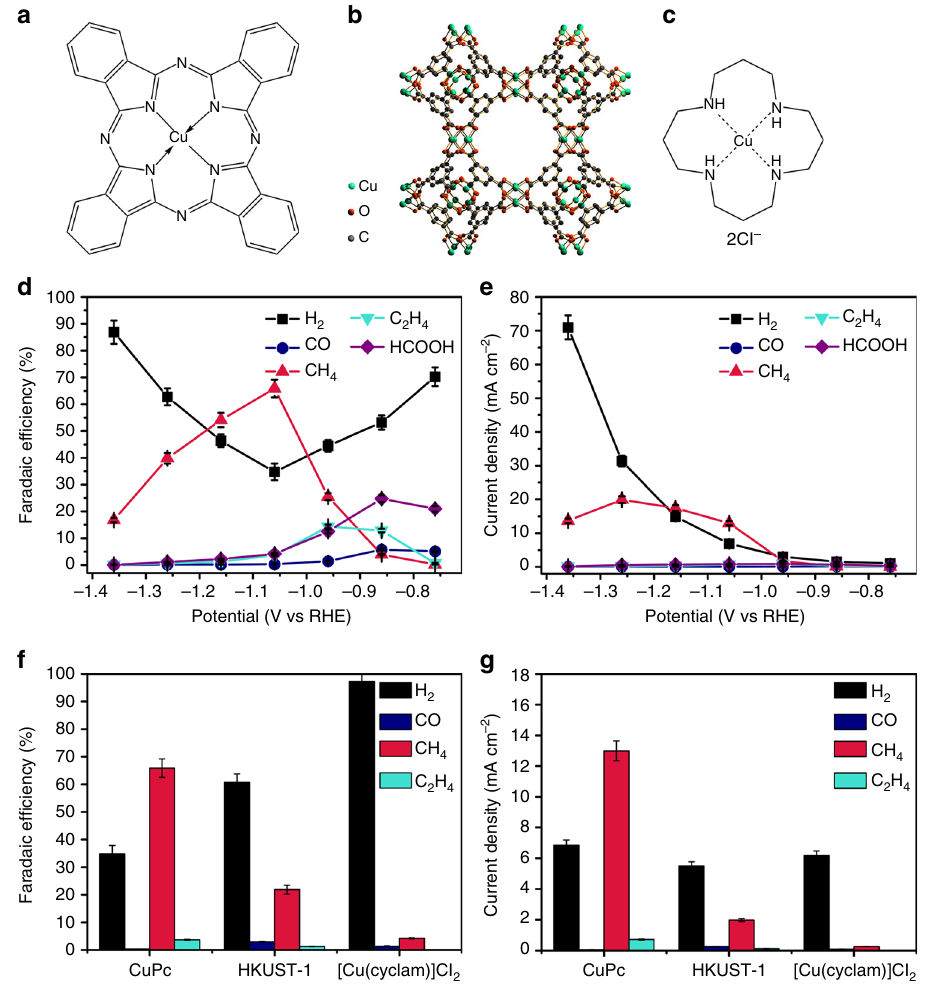
Fig. 1 Molecular structures of three Cu-complex materials and their electrocatalytic performance for CO 2 reduction. Molecular structures of a CuPc, b HKUST-1, and c [Cu(cyclam)]Cl 2 . Potential-dependent d Faradaic ef fi ciencies and e partial current densities of products for CO 2 electroreduction reaction catalyzed by CuPc. Comparison of f Faradaic ef fi ciency and g partial current density distributions among CO 2 electroreduction reactions catalyzed by the three materials at – 1.06 V vs RHE. Error bars represent the SD from multiple re fl ect stable states under the electrochemical conditions. Under